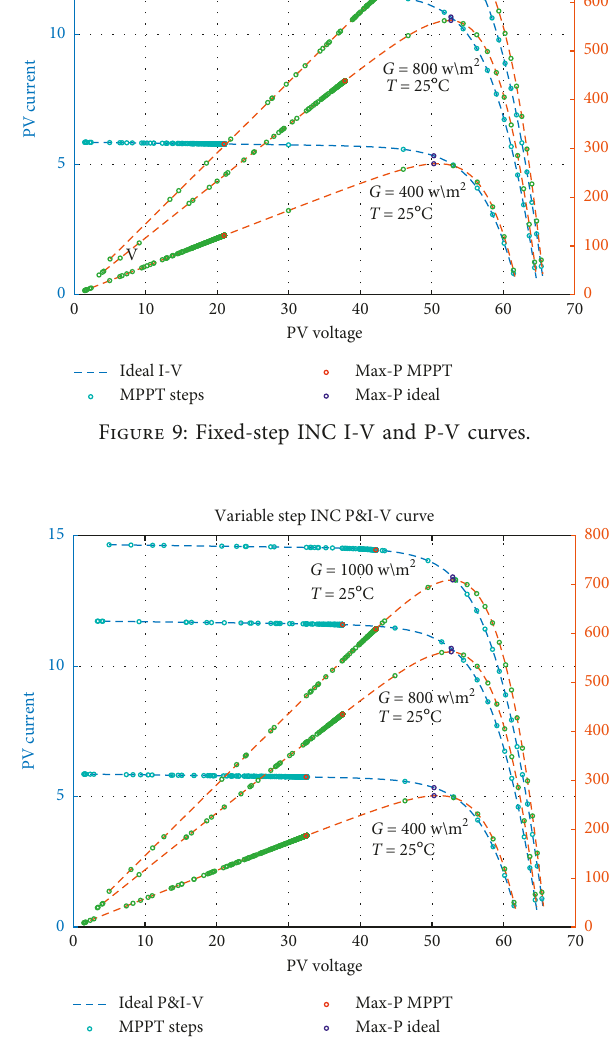
Figure 10: Variable-step INC I-V and P-V curves.